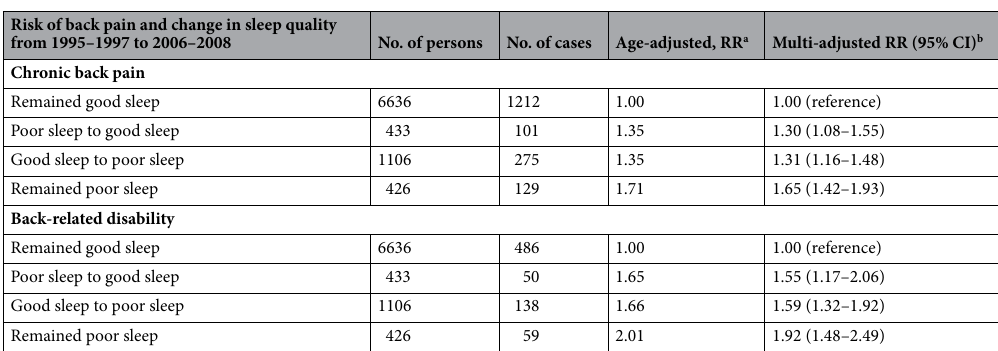
Table 2. Risk of chronic back pain and back-related disability at follow-up in 2017–2019 associated with change in sleep quality from 1995–1997 to 2006–2008. CI confidence interval, RR risk ratio. a Adjusted for age (continuous). b Adjusted for age (continuous), sex (women, men), education (primary school, high school, college ≤ 4 years, college > 4 years), body mass index (continuous), relative change in body weight (continuous), changes in physical activity (remained active, inactive to active, active to inactive, remained inactive), and smoking (never smoked, former smoker, current low-intensity smoker [< 10 cigarettes per day], medium-intensity smoker [10–19 cigarettes per day] and high-intensity smoker [20 or more cigarettes per